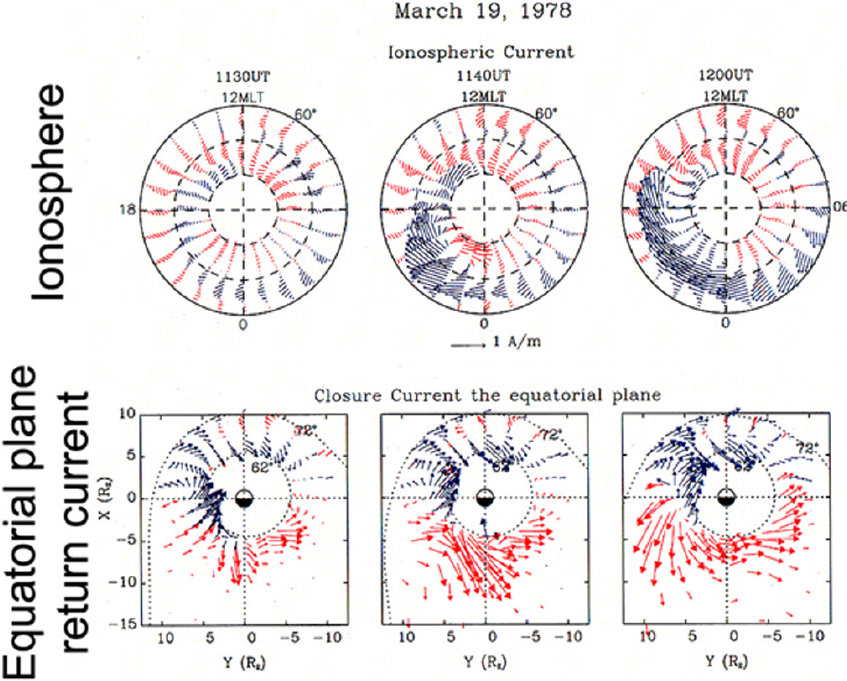
Fig. 15b. The possible return current distribution of the westward electrojet. The distribution of the ionospheric currents (upper) is projected on the equatorial plane (lower). In the lower part, the projected westward electrojet vectors are shown in red (cf. Akasofu, 2007, p. 106).